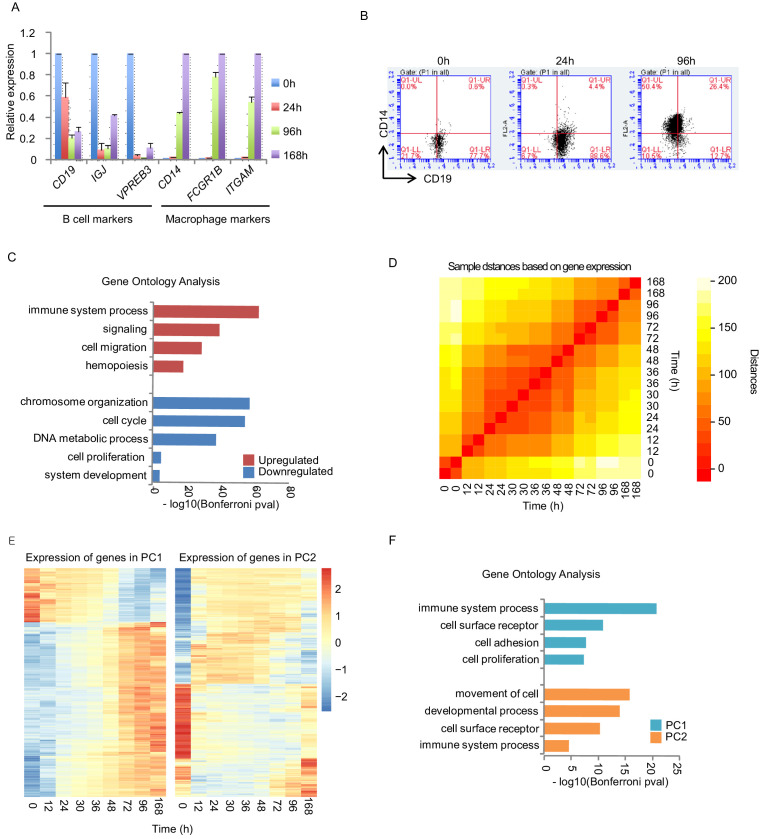
Transcription activity during transdifferentiation.(A) B-cell or macrophage marker gene expressions during the transdifferentiation are tested by quantitative PCR (qPCR). C/EBPα was induced for 0 hr, 24 hr, 96 hr, and 168 hr. Gene expressions of indicated genes were quantified using GAPDH expression. Relative expression to 0 hr for B cell markers and to 168 hr for macrophage markers is shown. Standard deviation from three independent experiments are shown as error bars. (B) FACS analysis with antibodies against CD19 (B-cell specific surface marker) and CD14 (macrophage specific surface marker). (C) Gene ontology analysis on the upregulated or downregulated genes during the transdifferentiation, determined by RNA-seq. Bonferroni corrected p-values were transformed by log10. (D) Heatmap of sample distances (similarities) between the indicated time points based on gene expressions during the transdifferentiation. (E) Heatmap of gene expression in principle component 1 or 2 (PC1 or 2) from Figure 1D. (F) Gene ontology analysis on the PC1 or two from E and Figure 1D.